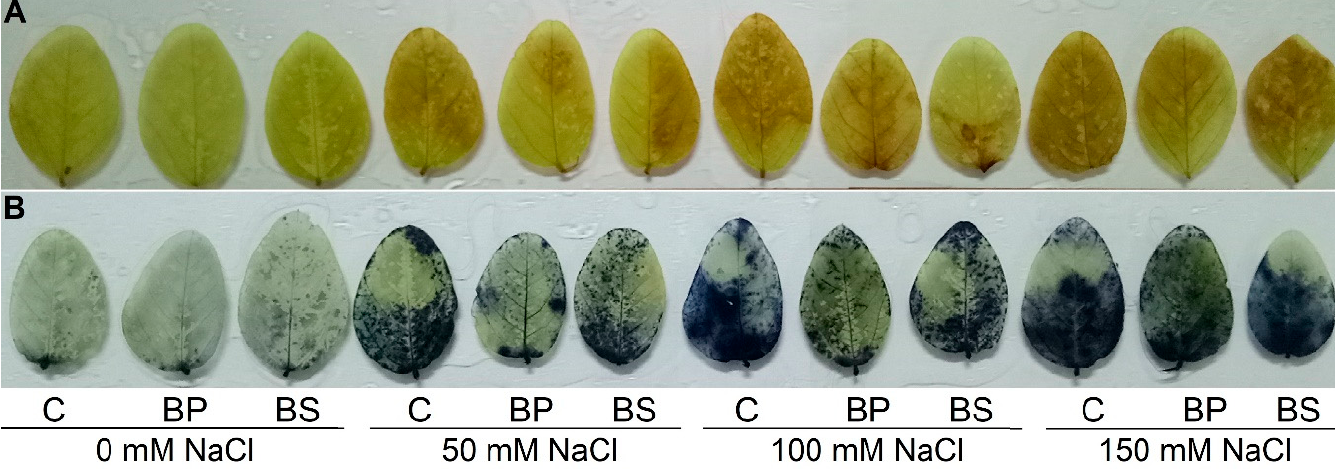
Figure 5. Localization of the spots of H 2 O 2 ( A ) and O 2• − radicals ( B ) on the leaves of soybean ( Glycine max cv. BARI Soybean-5) as affected by Bacillus subtilis in response to different concentrations of salt stress. Here, C, BP, and BS indicate the control, seed inoculation with Bacillus subtilis , and soil inoculation with Bacillus subtilis , respectively.